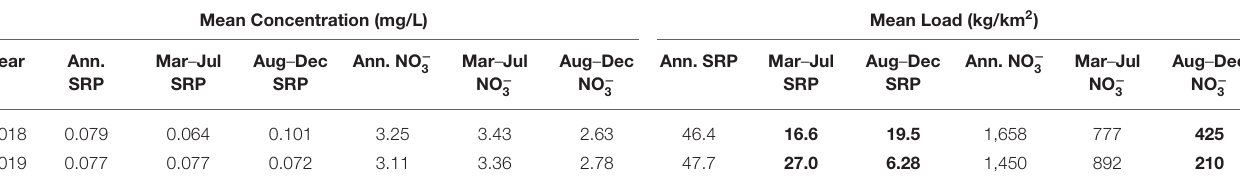
TABLE 3 | Mean annual and March–July (Mar–Jul) soluble reactive phosphorus (SRP) and nitrate (NO − 3 ) concentrations and loads for 2018 and